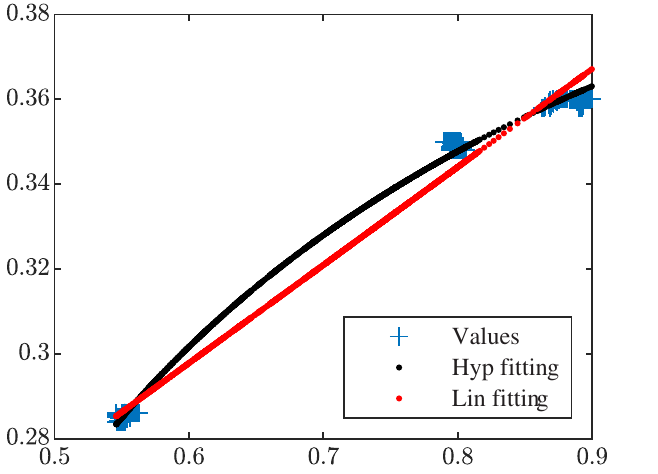
Fig 2. Fitting of linear (red) and hyperbolic (black) regression models to a patient’s QT and RR data (“highCAD- 4” in Table 1). The data clusters correspond to the different windows W 4.27 and 1.75 ms for the linear and hyperbolic fittings,